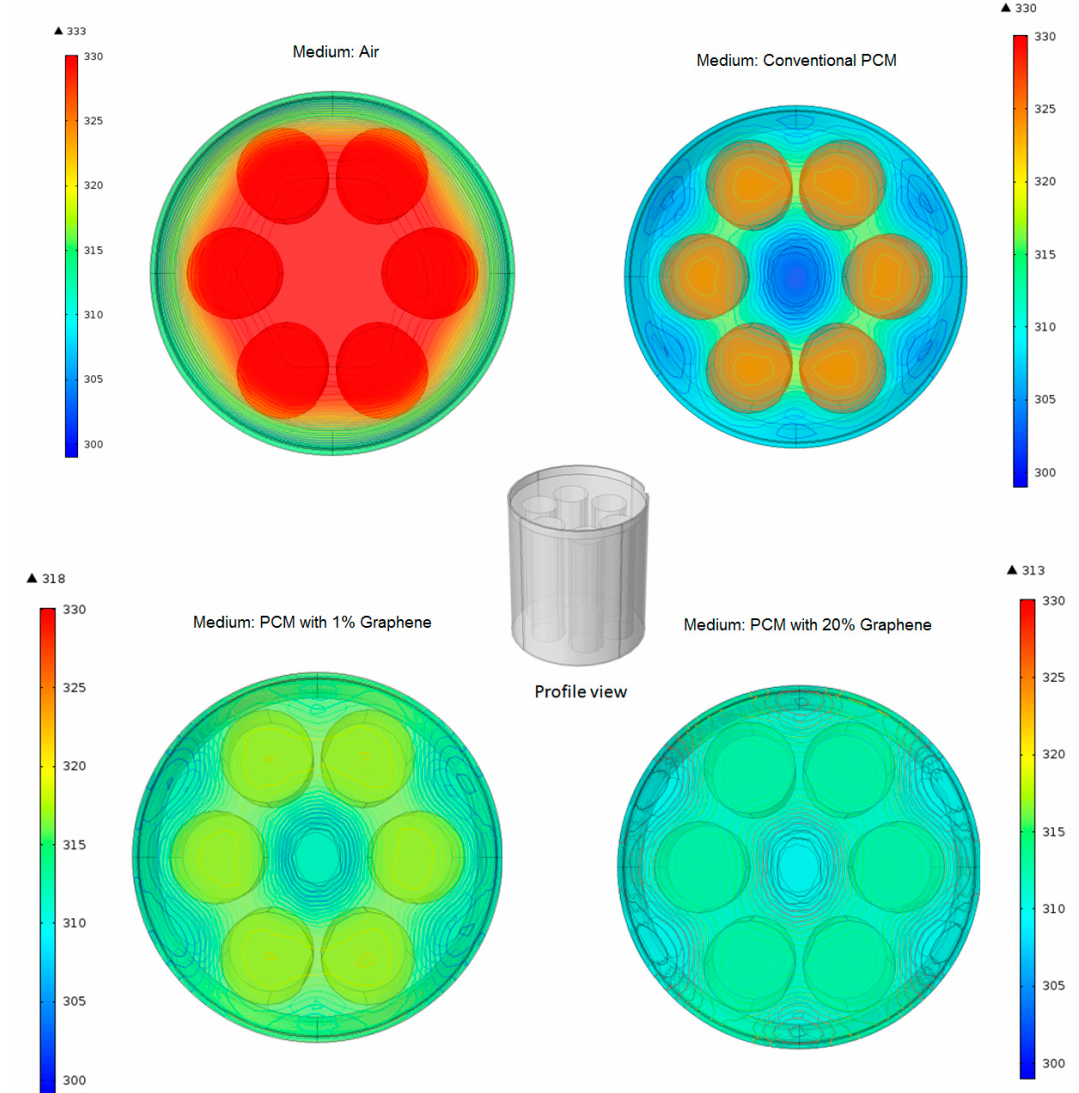
Figure 6. Schematic of the battery pack and simulated temperature rise. The structure parameters correspond to the experimentally tested batteries. Modeling based optimization of the materials and pack parameters are essential for practical applications of graphene-enhanced PCMs in energy storage